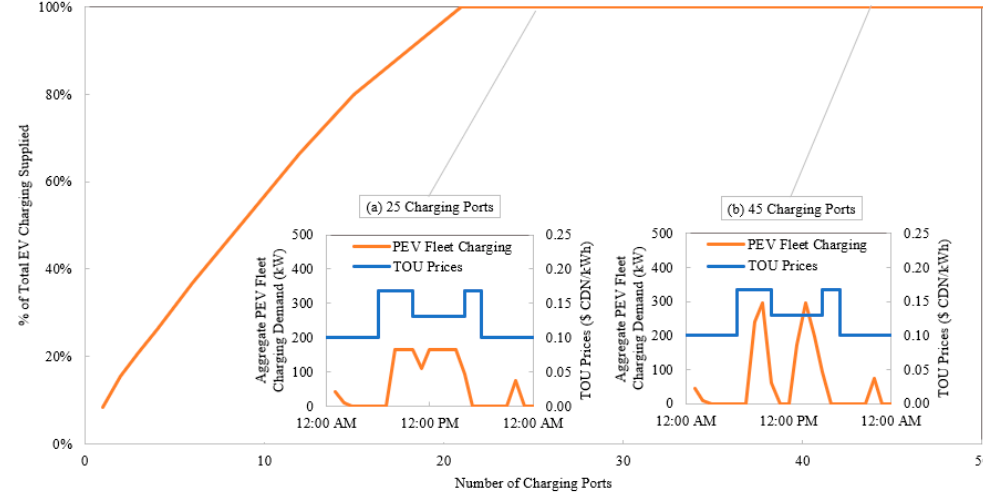
Figure 7 . Charging delivered to EV fleet with increasing availability of charging infrastructure. EV fleet charging profiles are shown for ( a ) 25 charging ports and ( b ) 45 charging ports. TOU—time-of-use.